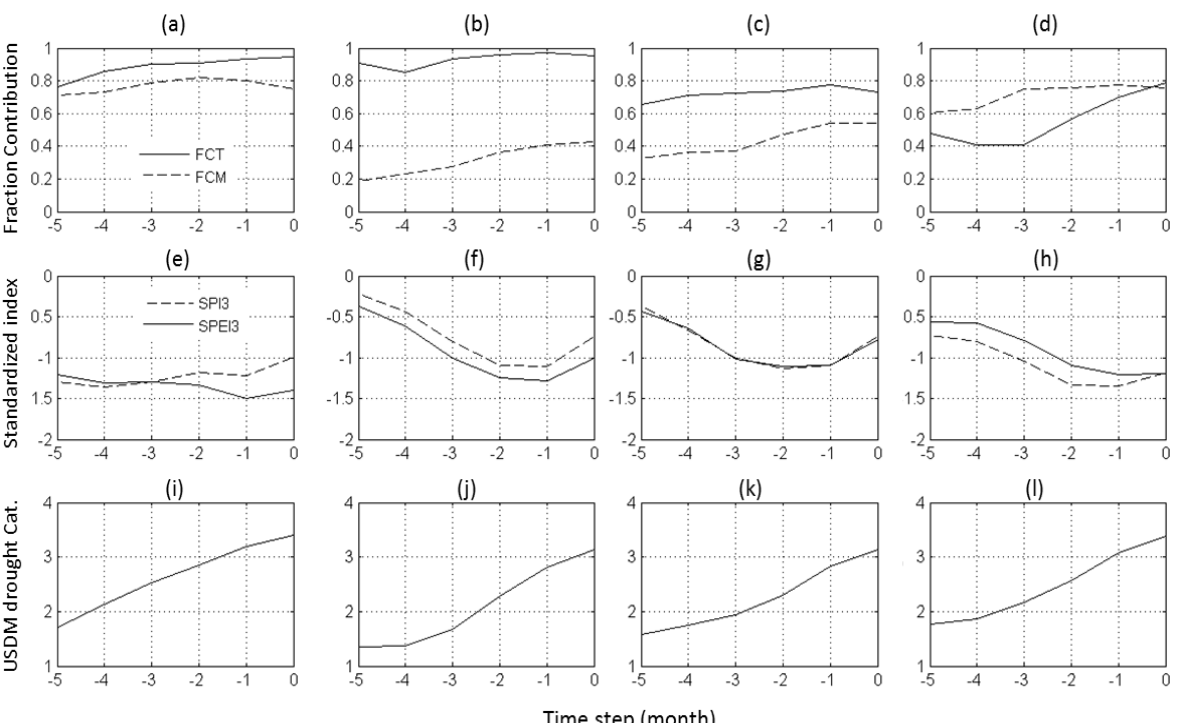
Figure 8. The cluster averages of the time series plotted separately for each group identified in Figure 7. From left to light the columns represent groups 1 to 4, respectively. The top row ( a – d ) shows the fraction of positively contributing temperature (FCT) and moisture (FCM) to VPD, the middle row ( e – h ) shows the standardized indices (here, SPI3 and SPEI3) as drought reaches an extreme or exceptional USDM categories at time step 0 (t o in text), and the bottom row ( i – l ) represents USDM drought